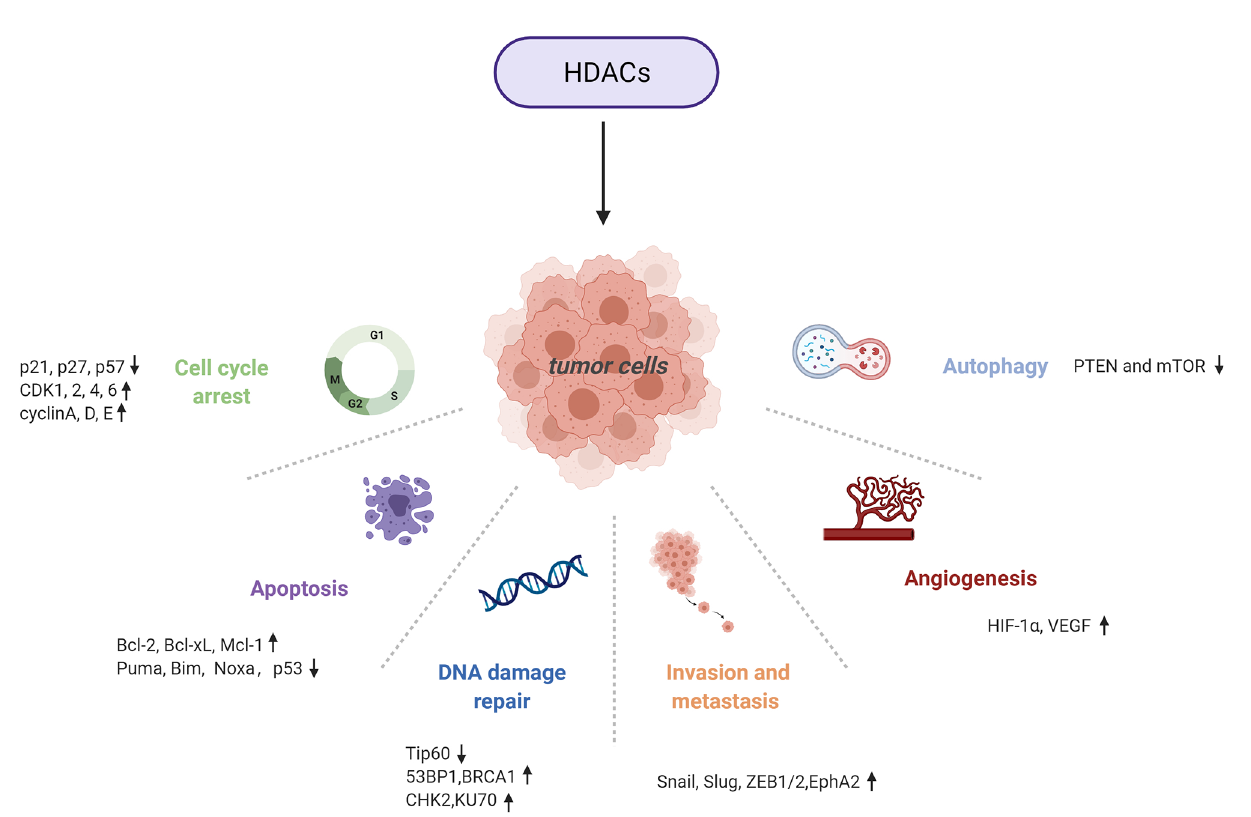
FIGURE 3 | Multiple tumorigenic pathways activated by HDACs. An overview of HDAC-involved tumorigenic processes, including the cell cycle, apoptosis, DNA damage repair, metastasis, angiogenesis, and